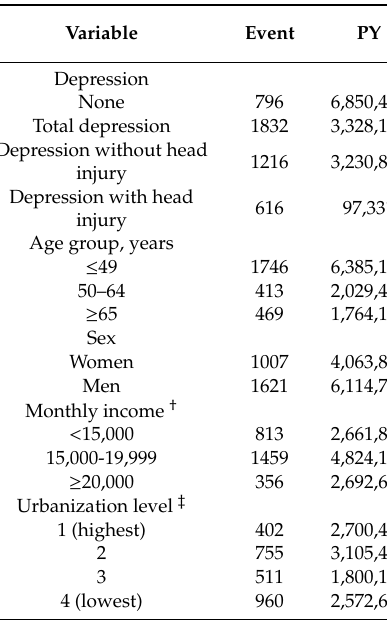
Figure 1. Comparison of the cumulative incidence of ( A ) suicide attempt and ( B ) suicidal drug overdose among patients with depression with head injury, patients with depression without head injury, and comparison group from the general population. Table 2. Incidences and risk factors associated with various factors for suicide